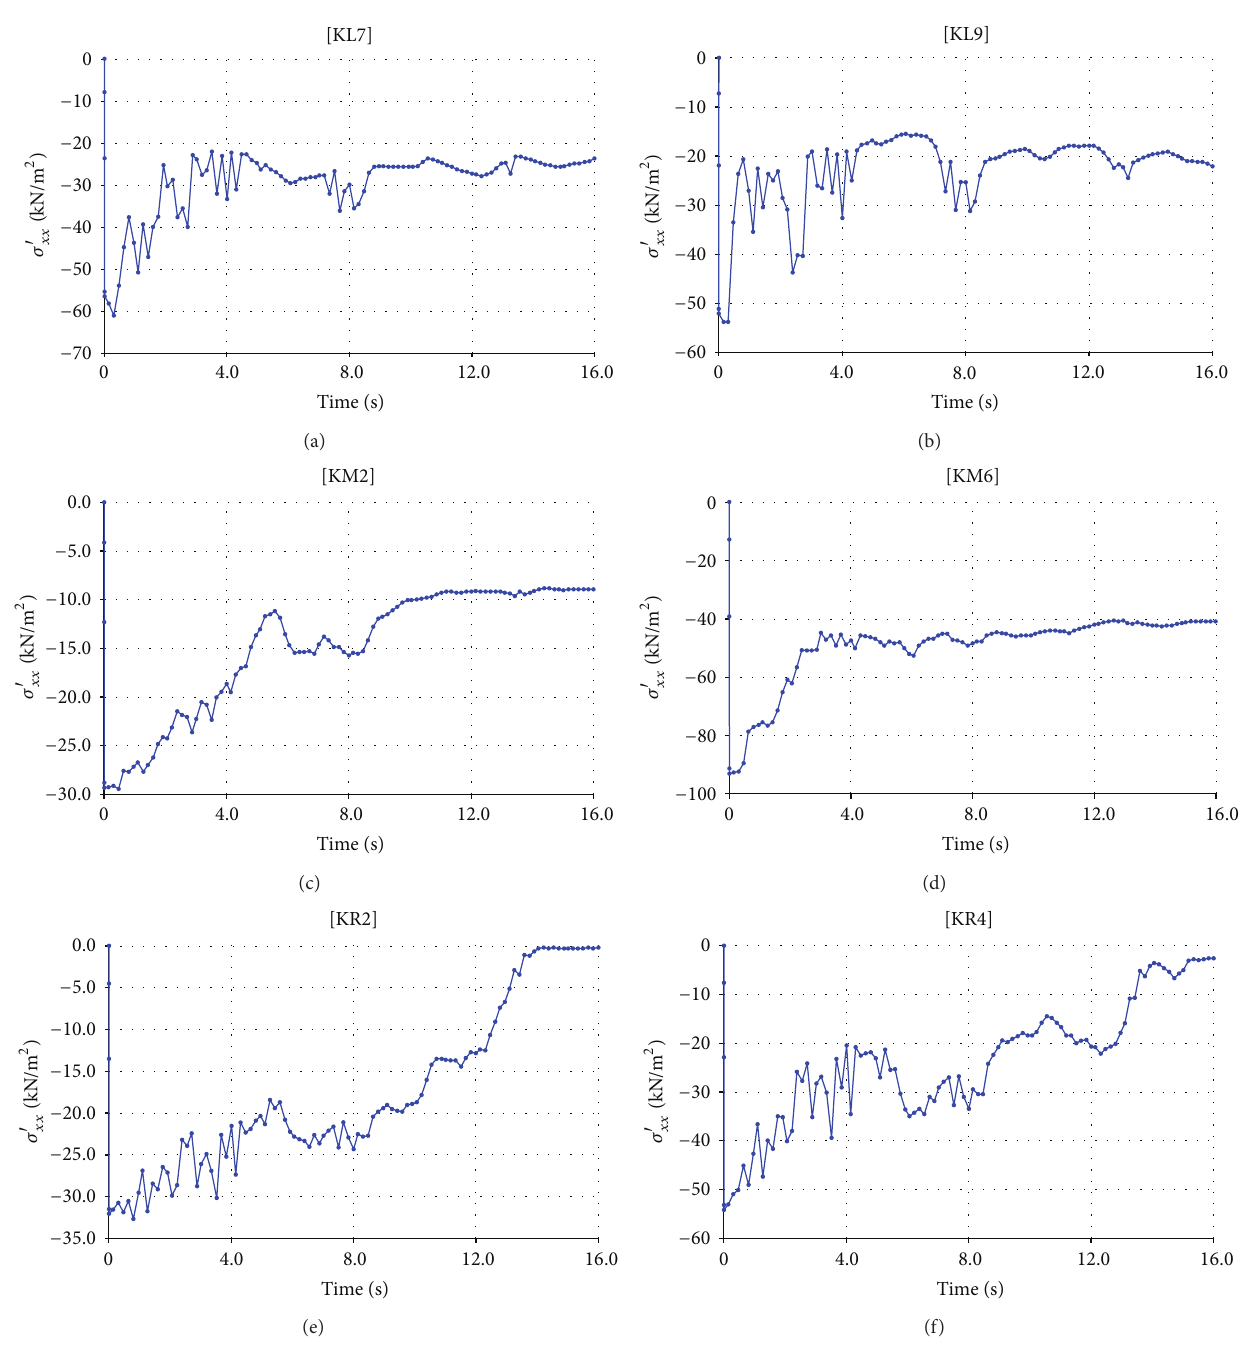
Figure 12: Stress-time curves for Kitayama